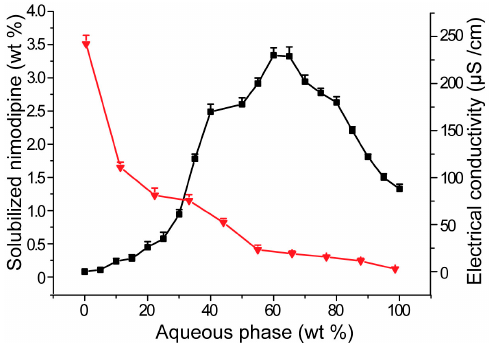
Figure 2. Nimodipine solubilization capacity ( (cid:72) ) and the electrical conductivity ( (cid:110) ) of SMEDDS upon dilution with water ( n = 3).